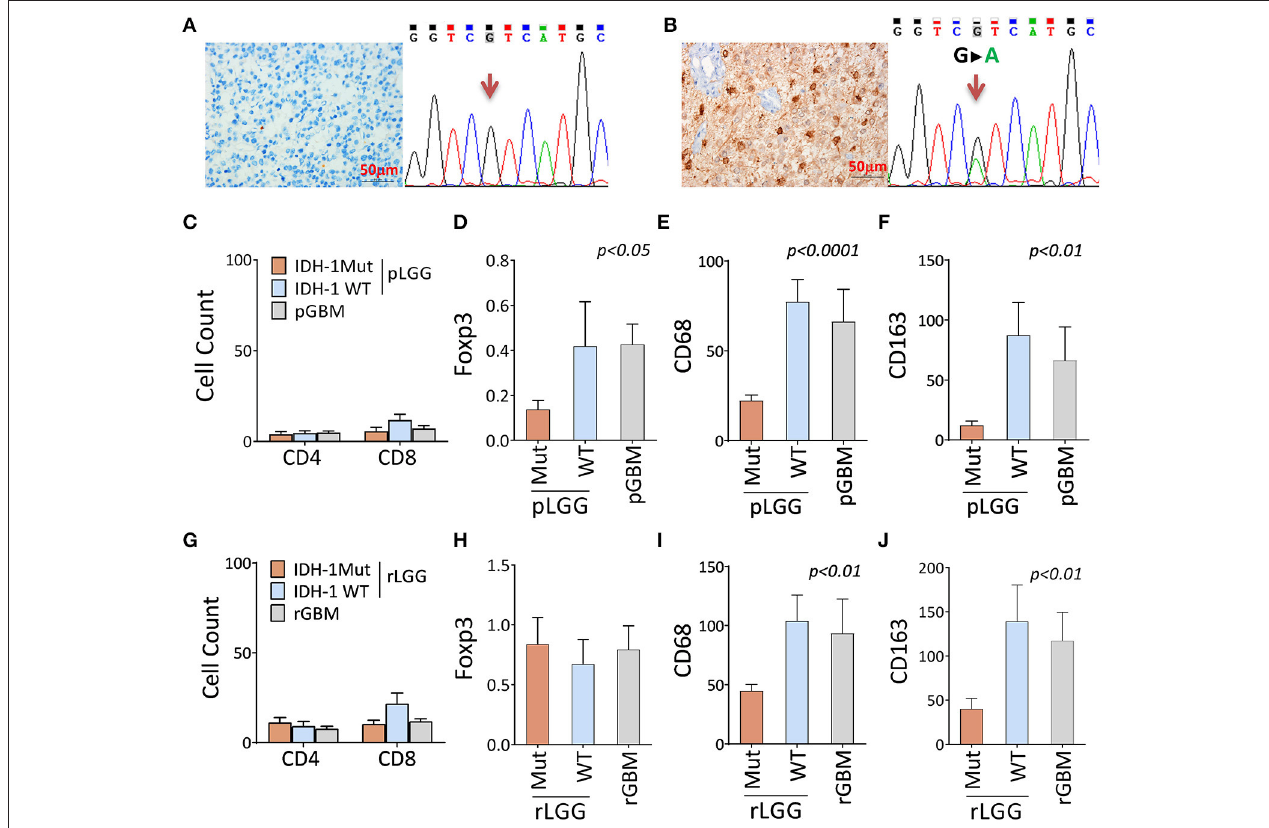
FIGURE 2 | There were fewer immune-suppressive cell infiltrates in tumors with the IDH1 mutation compared with the IDH1 wildtype in primary and recurrent/secondary tumors. (A,B) Identification of the IDH1 mutation by DNA sequencing and antibody staining. A representative result of the IDH1 mutation, as determined by the anti-IDH1 mutation (R132H)-specific antibody and DNA sequence. (C–F) The immune infiltrates between patients with and without IDH1 mutation in primary LGG (pLGG) and GBM (pGBM) for CD4 + , CD8 + , and Foxp3 + T cells and CD68 and CD163 macrophages. (G–J) The immune infiltrates differ between patients with and without IDH1 mutations in recurrent LGG (rLGG) and GBM (rGBM) for the same markers. A total of 35 pairs of LGGs and 15 pairs of GBMs (pre- and post-tumor progression, as described in Table S2) were analyzed by immunohistochemistry staining for T cell subset makers (CD4, CD8, and Foxp3 + cells) and macrophage markers (CD68 and CD163). The immune infiltrates in the tumors were counted in three large regions. In each region, a mean of 10 consecutive high-power fields was recorded by experienced pathologists who were blinded to the patients’ clinical information. The average counts of the three regions were used for the final report. The difference among the three groups was analyzed using one-way ANOVA. Any difference among group means and post hoc pairwise comparisons among tumor types were performed using FDR-adjusted P -values.